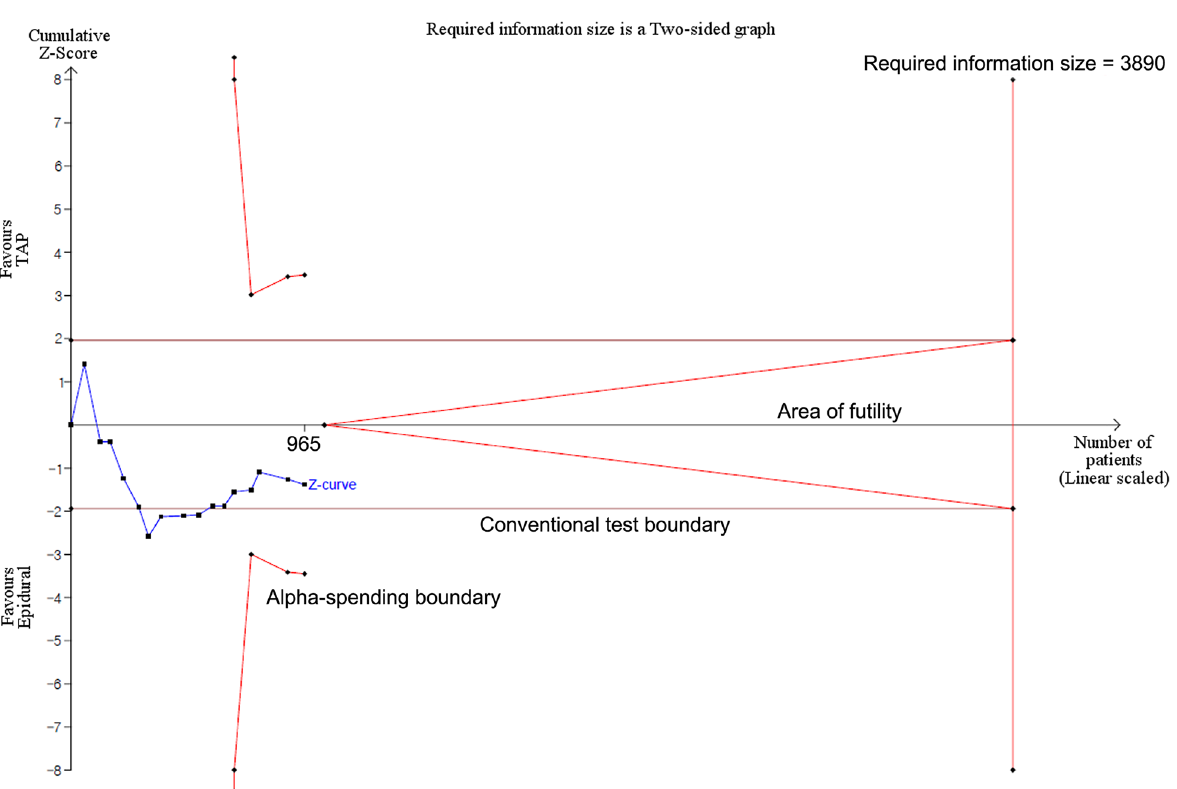
Figure 6. Trial sequential analysis for the pain score at rest at 24